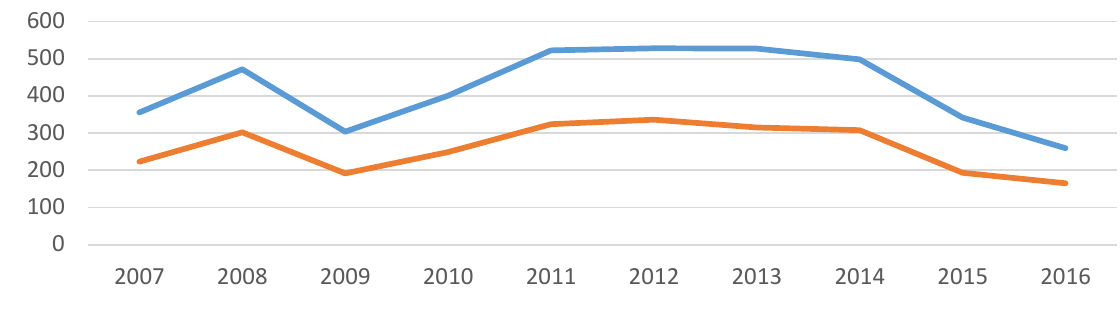
Figure 2. The volume of exports and imports of Russia in the period